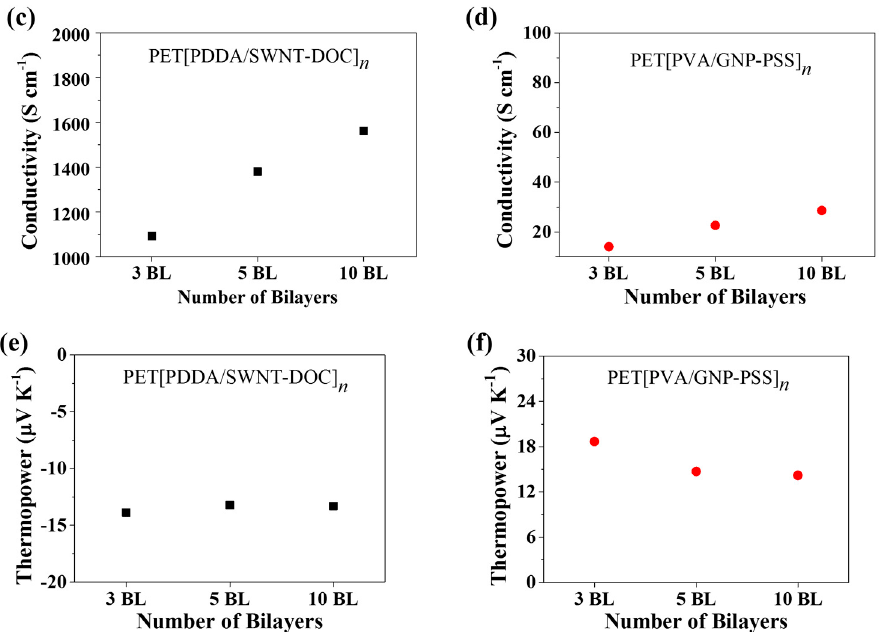
Figure 5. ( a , b ) Electrical resistance of PET[PDDA/SWNT-DOC] n ( n = 3, 5, 10) and PET[PVA/GNP-PSS] n ( n = 3, 5, 10) LbL thin films. ( c , d ) Electrical conductivity of PET[PDDA/SWNT-DOC] n ( n = 3, 5, 10) and PET[PVA/GNP-PSS] n ( n = 3, 5, 10) LbL thin films. ( e , f ) Thermopower (Seebeck coefficient) of PET[PDDA/SWNT-DOC] n ( n = 3, 5, 10) and PET[PVA/GNP-PSS] n ( n = 3, 5, 10) LbL thin films.